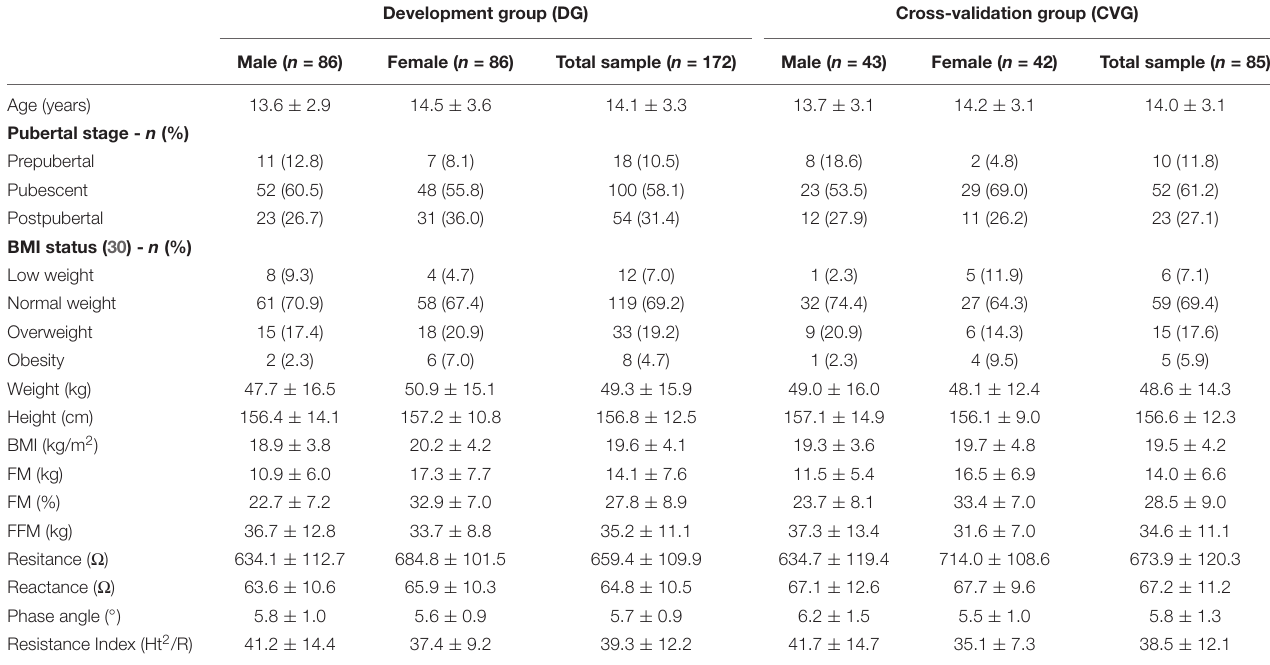
TABLE 1 | Descriptive [mean ± sd or n (%)] characteristics and body composition of development and cross-validation groups.